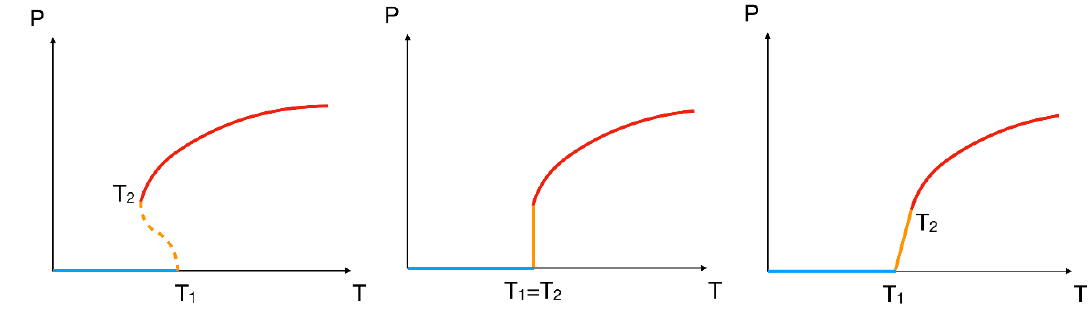
Figure 4 . Cartoon pictures of the Polyakov loop P as a function of temperature. The blue, orange and red lines represent the con(cid:12)ned, partially decon(cid:12)ned and completely decon(cid:12)ned phases. Similar curves are obtained by using E=N 2 as the vertical axis as